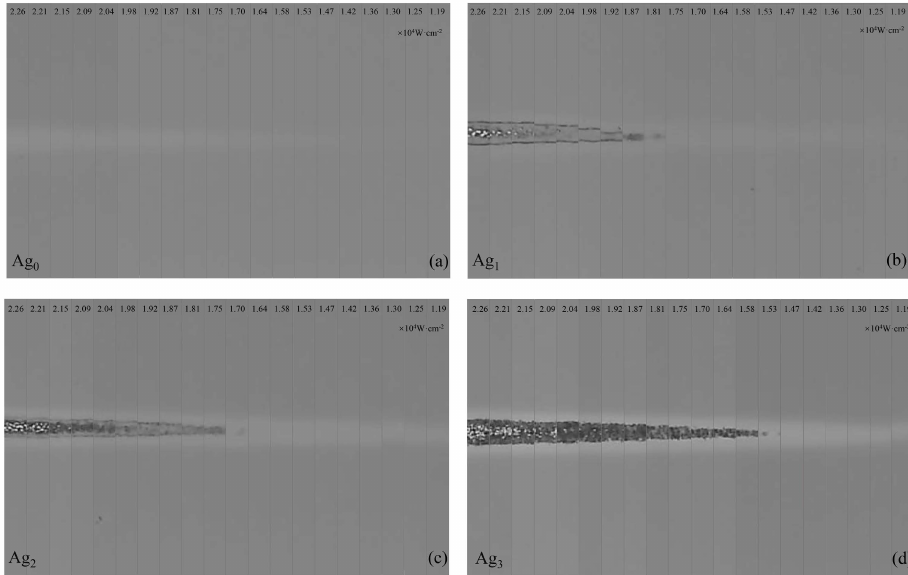
Figure 4. The normalized grayscale microscope pictures for different silver concentrations ( a ) Ag 0 , ( b ) Ag 1 , ( c ) Ag 2 , and ( d ) Ag 3 at an incident laser power density of 1.19 × 10 4 W/cm 2 to 2.26 × 10 4 W/cm 2 .